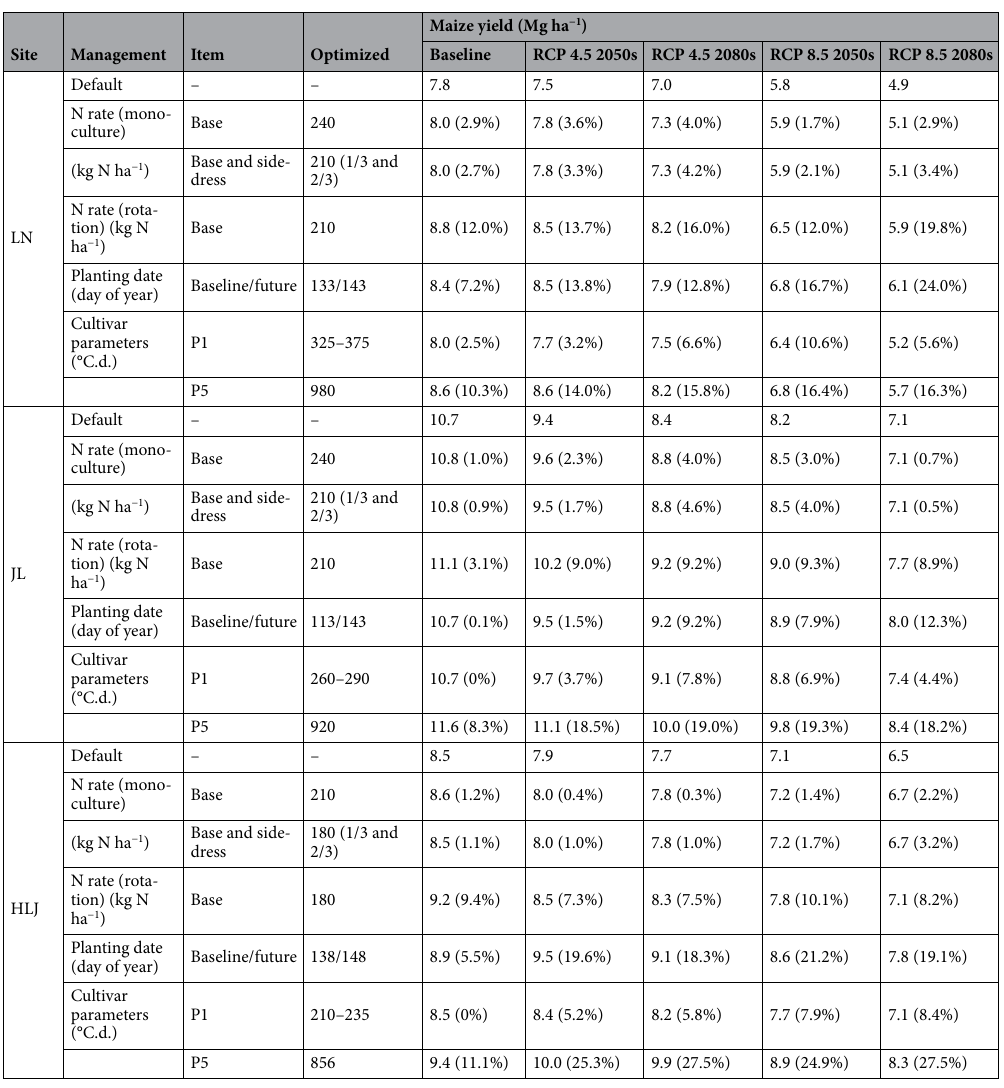
Table 2. Potential adaptation management practices for maize yields under climate change scenarios at Liaoning (LN), Jilin (JL) and Heilongjiang (HLJ) provinces in Northeast China. The content within the brackets represents the change of potential adaptation management practices on maize yields compared to the default. P1, Thermal time from seedling emergence to the end of the juvenile phase (degree days > 8 °C); P5, Thermal time from silking to physiological maturity (degree days > 8